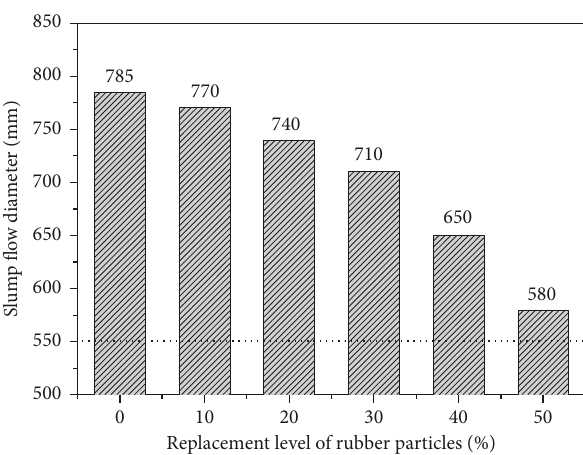
Figure 15: Influence of the replacement level of rubber particles on V-funnel flow time T v .